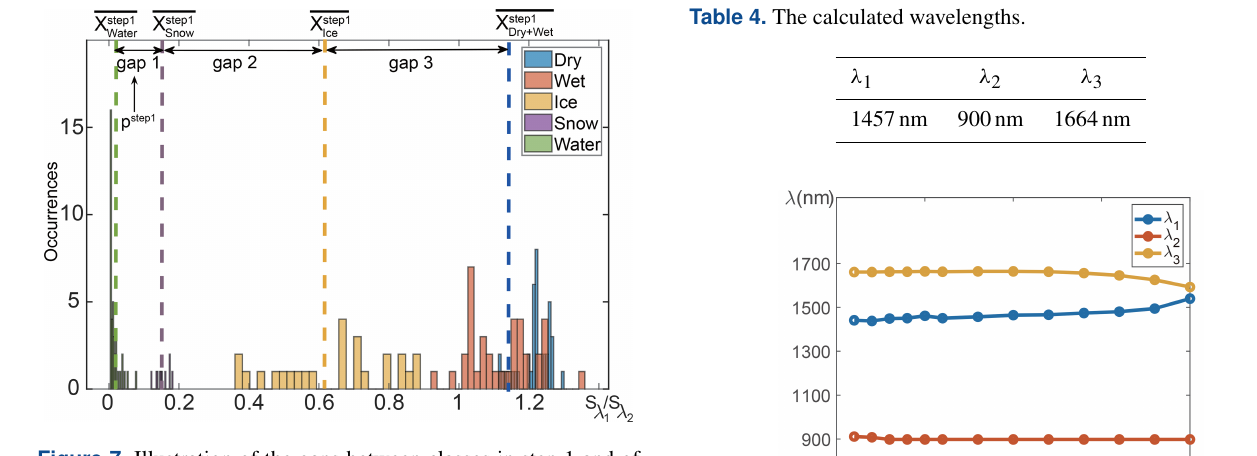
Figure 7. Illustration of the gaps between classes in step 1 and of the parameter p step1 . In this example, p step1 takes the value of the gap between water and snow classes.